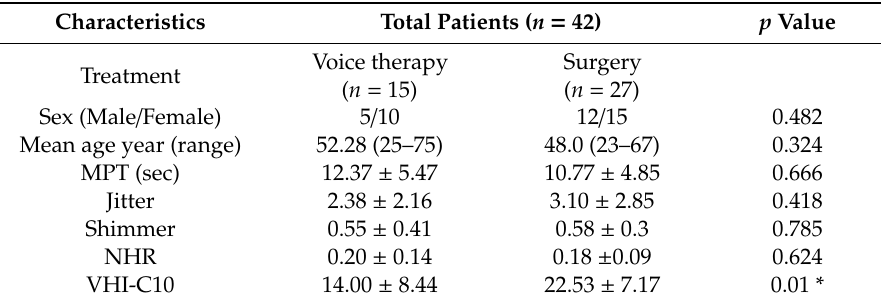
Table 1. Baseline characteristics and acoustic analysis of enrolled patients.